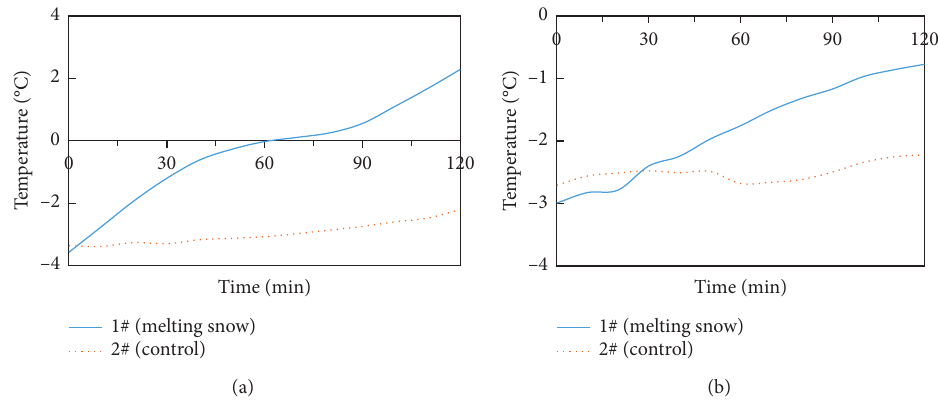
Figure 8: The asphalt pavement temperature variation with time. (a) 0.5cm depth. (b) 15 cm